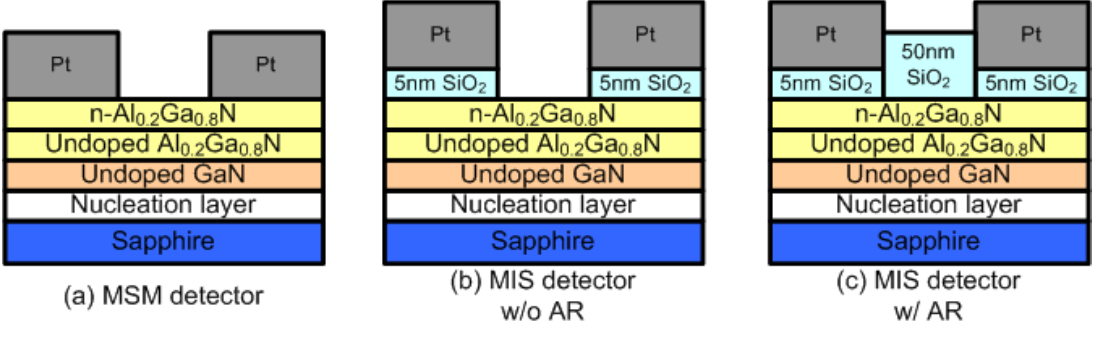
Figure 5. Three different AlGaN/GaN structures: (a) MSM detector; (b) MIS detector without anti-reflection coating and (c) MIS detector with anti-reflection coating. The 50 nm thick SiO layer in (c) acts as both a passivation layer and anti-reflection 2 coating. Reproduced from [23] with permission of Elsevier